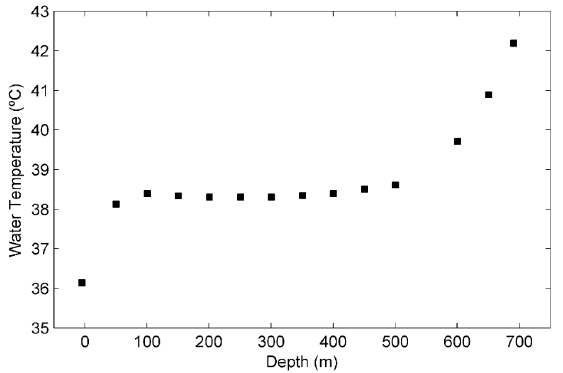
Figure 5. Fluid temperature profile built after processing the field data.